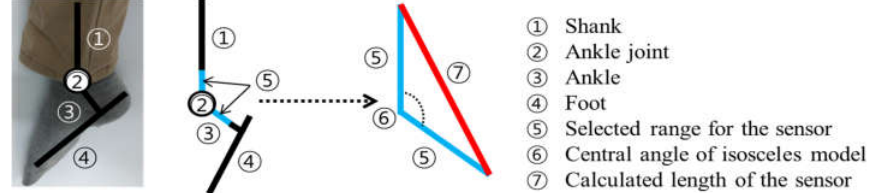
Figure 4. Determination of the isosceles model for determination of the sensor dimensions. Length of the sensor was decided by ⑤ and ⑥ .